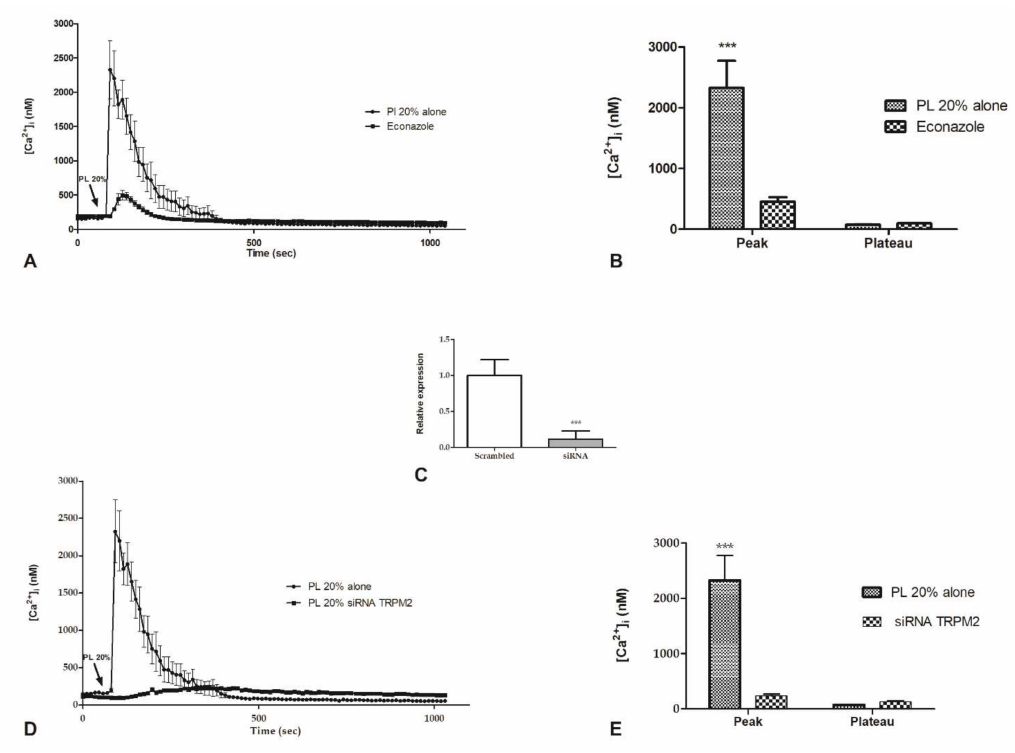
Figure 4. The inhibition of TRPM2 channel reduced PL-induced Ca 2 + entry. ( A ) PL-induced Ca 2 + entry was dramatically reduced in the presence of 10 µ M Econazole (30 min preincubation). PL was added